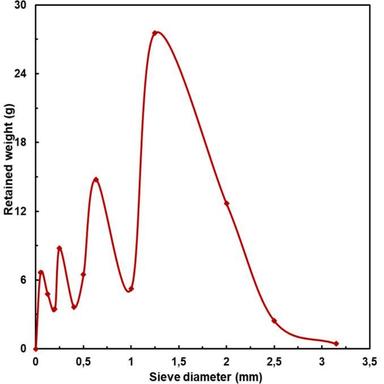
Particle size distribution of expanded perlite.